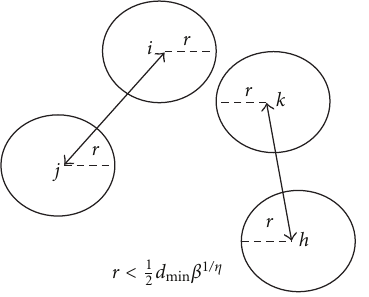
Figure 9: Disks of radius r centered at transmitters and receivers are